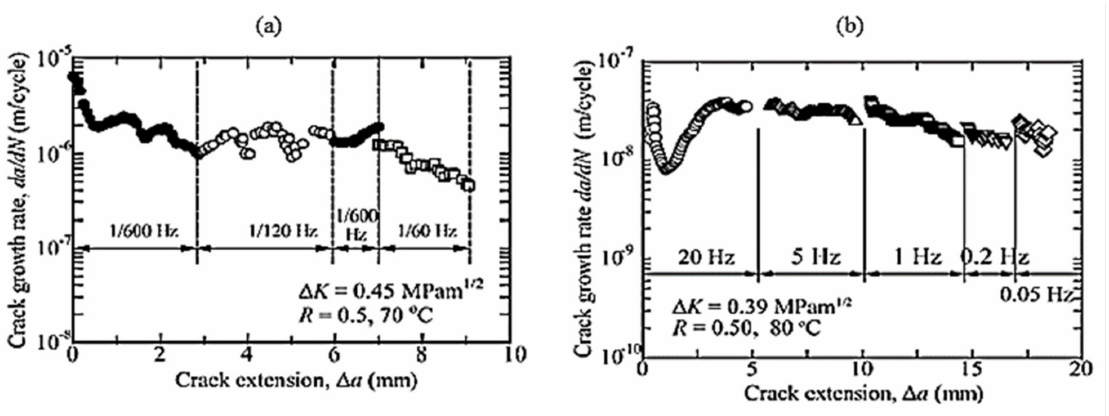
Figure 4. Impact of loading on mode 1 fatigue cracking of T300/3601laminates in water ( a ) cycle-dependent cracking rate, ( b ) time-dependent cracking rate [35].